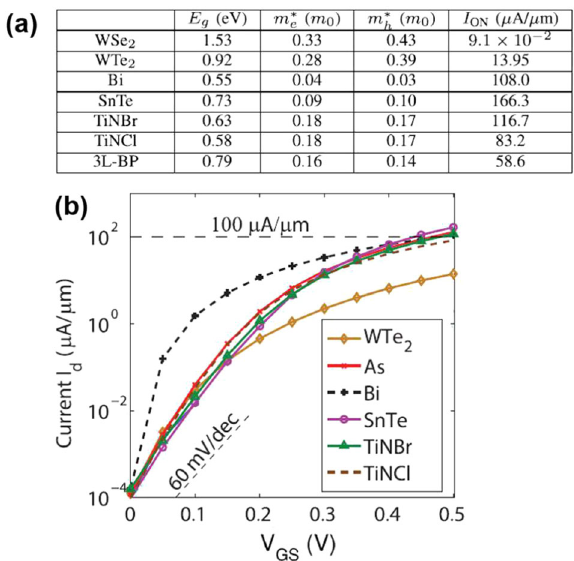
Fig. 20 Simulation Report of Nanoscale 2D-TFET. Comparative a material properties and drive currents and b transfer character- istics of mono chalcogenides and other 2D materials, adapted with permission from 92 . Copyright (2018)